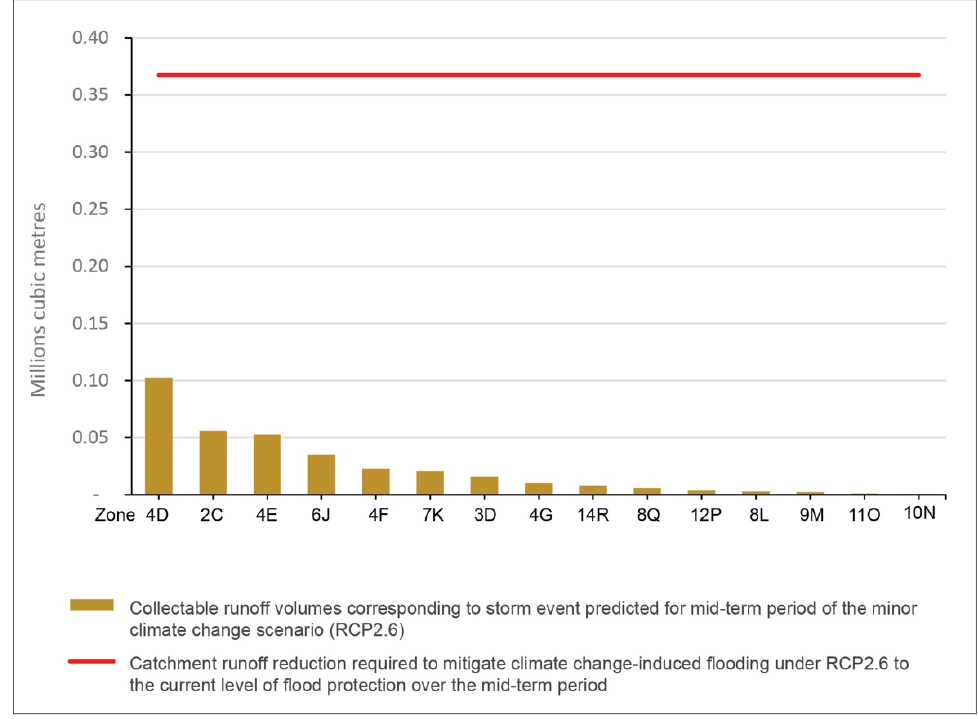
Figure 10. Collectable runoff volumes of all 15 SWM zones were classified as FMC class-VI. These zones can only capture a small proportion of that required to maintain the flood protection objective under the minor climate change scenario (RCP2.6) in the mid-term (red line).